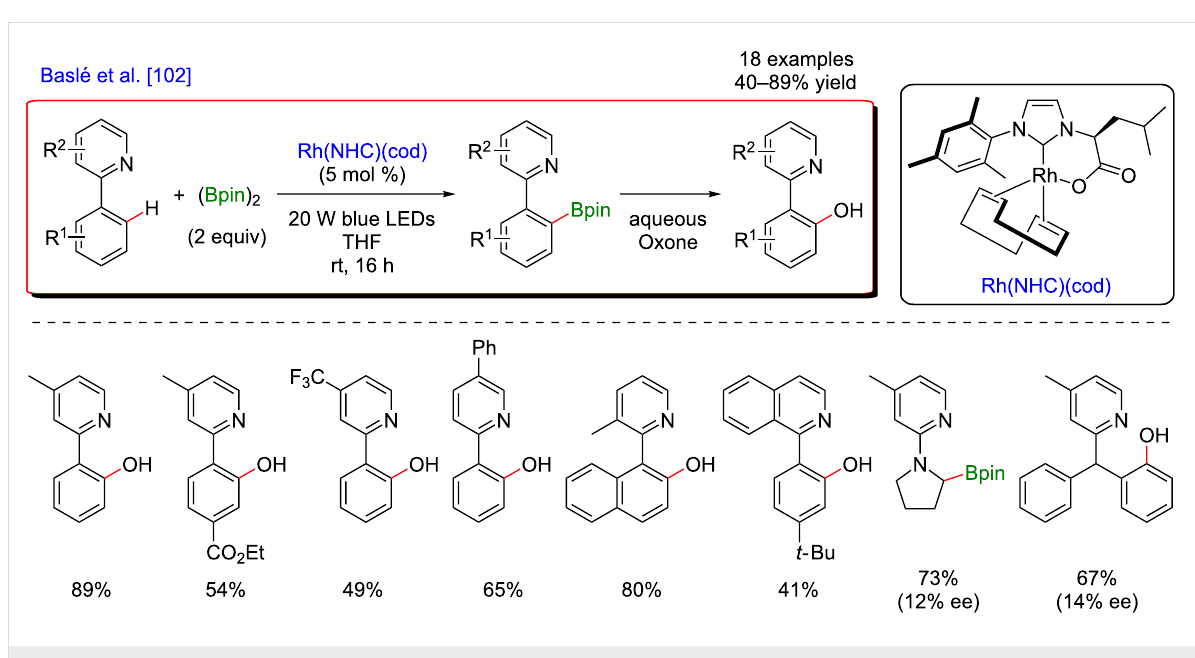
Figure 40: C–H borylation of arenes via visible-light